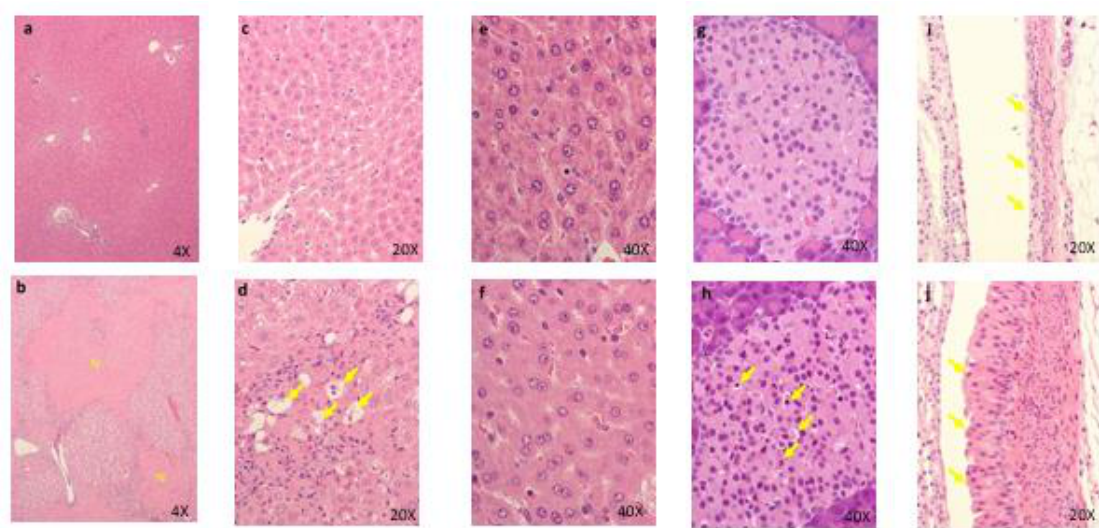
Figure 1: Histopathological findings in liver. control (a)(c)(e), 600 mg/kg (b)(d)(f); a , No abnormalities detected. b , Focal necrosis of hepatocytes in the central zone of lobules( N ) are seen. c , No abnormal- ities detected. d , Many balloon–like hepatocytes (arrows) are seen. No abnormalities detected. e , No abnormalities detected. f , Diffuse granular eosinophilic cytoplasm of hepatocytes are seen. No abnor- malities detected. Histopathological findings in pancreas. control (g), 600 mg/kg (h), g , No abnormalities detected. No abnormalities detected. h , Several necrotic islet cells (arrows) are seen. No abnormalities detected. Histopathological findings in kidney. control (i), 600 mg/kg (j), i , No abnormalities detected. No abnormalities detected. j , Hypertrophy of transitional cells are seen. Arrows: transitional